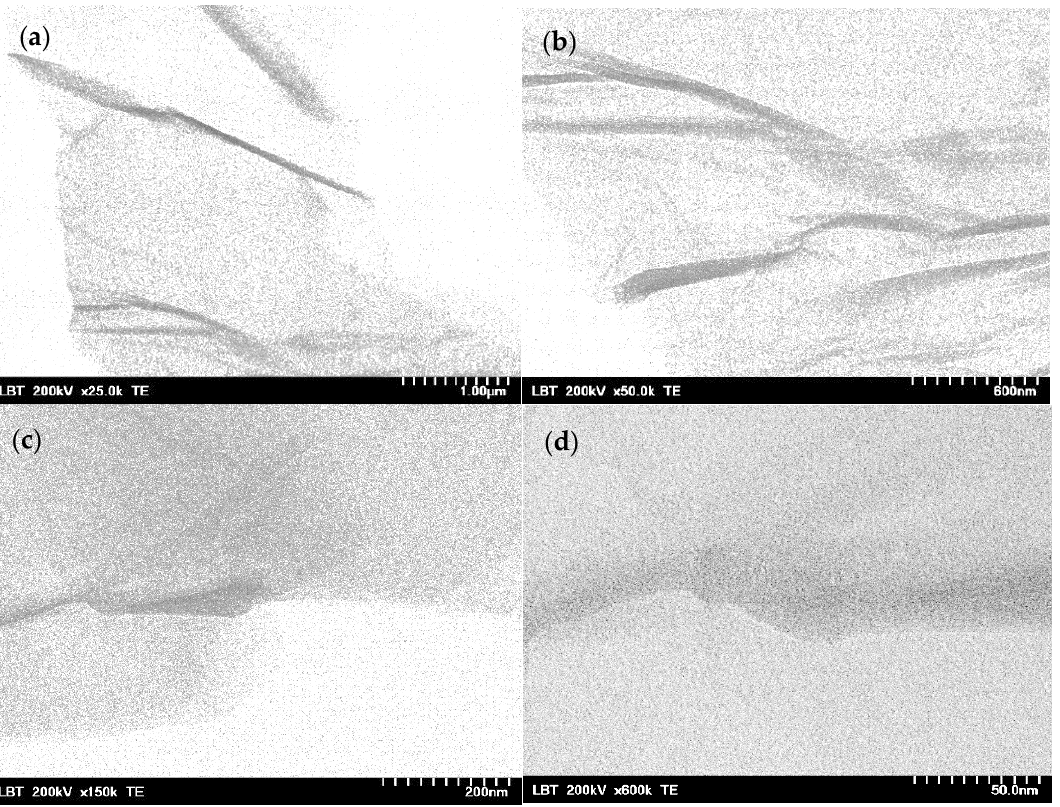
Figure 4. TEM images of GO suspension at various degrees of magnification: × 25.0 k ( a ), × 50.0 k ( b ), × 150 k ( c ) and × 600 k ( d ).